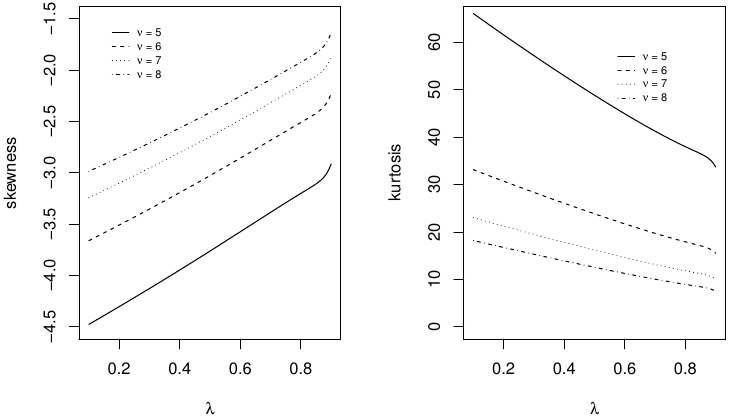
Figure 7. Skewness and kurtosis plots of the LiPa1 distribution as a function of parameter λ .